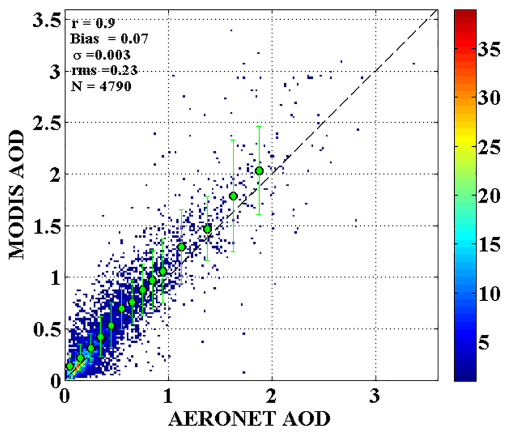
Figure 7. Density scatterplot of ATSR-retrieved AOD, using ADV v2.31, over China for the years 2002–2012 vs. AOD from AERONET stations in mainland China (see Fig. 1 and Table S1 in the Supplement). The filled circles are the averaged ATSR AOD binned in 0.1 AERONET AOD intervals (0.2 for AERONET AOD > 1.0) and the vertical lines on each circle represent the 1 σ SD of the fits. Statistics in the upper left corner indicate correlation coefficient r , bias, SD, root mean square (rms) error and number of data points ( N ). The color bar on the right indicates the number of data points.